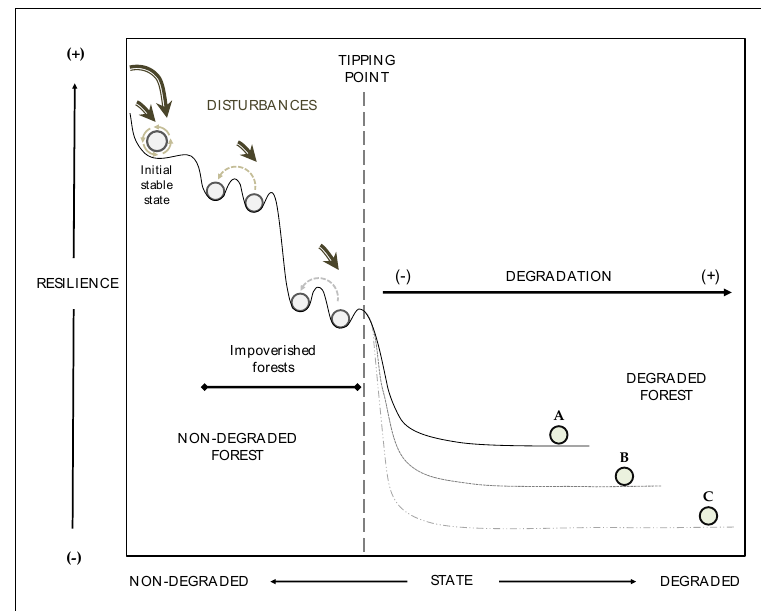
Figure 1. Theoretical illustration of the “tipping point” or “ecological threshold” at which a forest becomes degraded. A forest subjected to pressures—either small but sustained, or brief but highly intense—will at some point lose its capacity to recover. The state of the degraded forest is presented as a degradation gradient, depending on whether the changes to the structural and functional characteristics of the forest were partial or total. The degraded forest may be in an alternative stable state if the changes to composition and structure are stable and the system is simply unable, by itself and in the short term, to return to its original stable state. Examples of different states of degradation are state A, low degradation; state B, medium degradation; and state C, high degradation (modified of diagrams originally formulated by [37,51]).